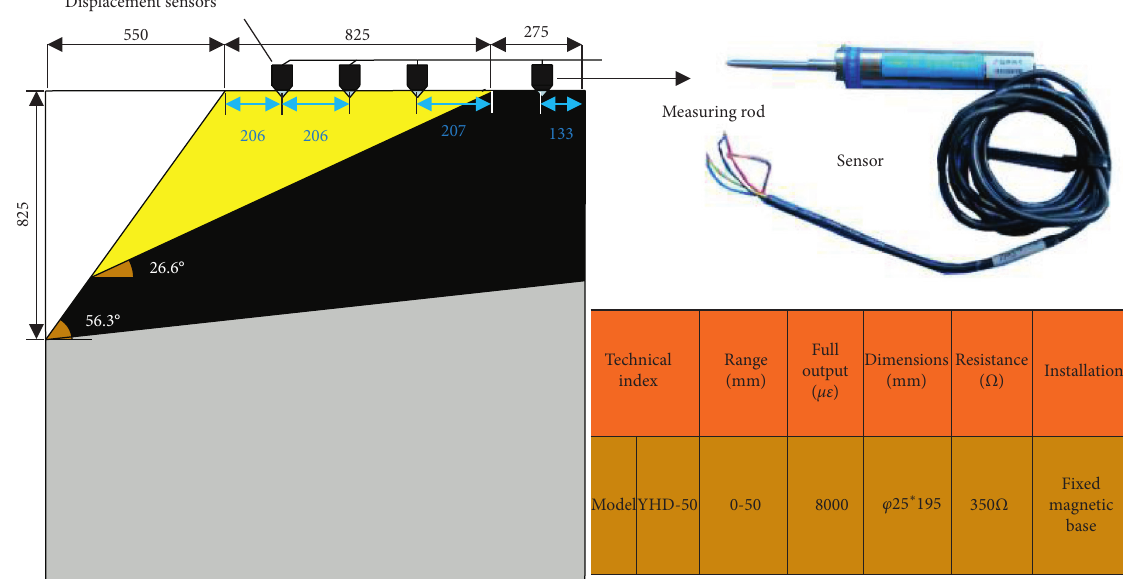
Figure 6: Schematic diagram of the displacement meter